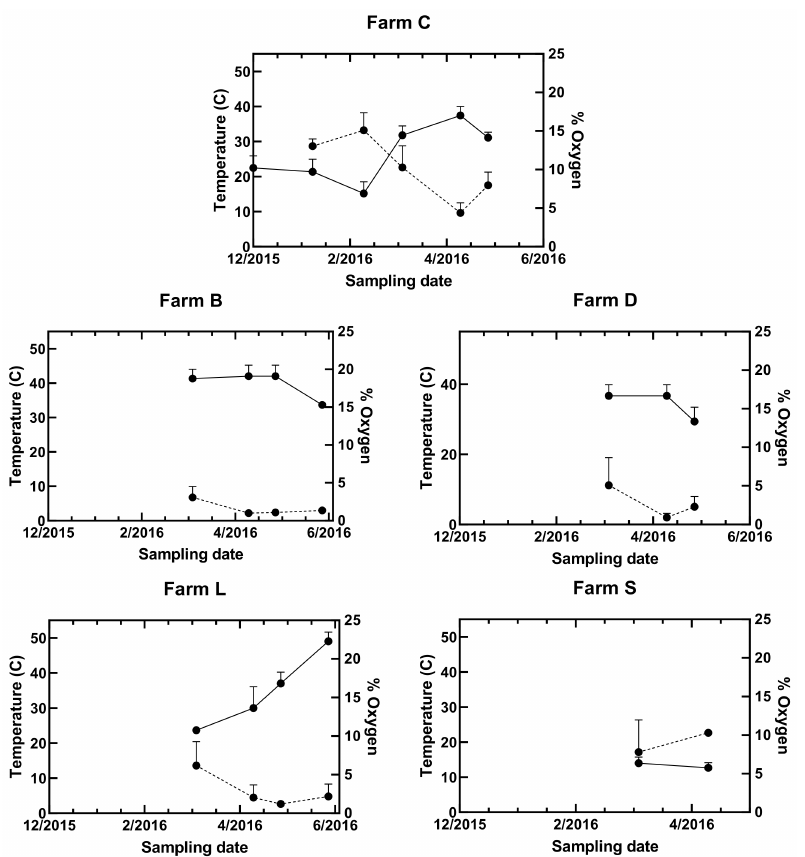
Figure 2. Temperature (solid line) and percent oxygen (dashed line) in the oxic zone in bedded pack at five farms. Means ( ± standard error) are illustrated. Farm C was the reference farm ( n = 10) and four additional farms were compared ( n = 3 replicate measurements per time). Some error bars cannot be seen because they are smaller than the symbols, except for the 4/2016 measurement at farm S that had only 1